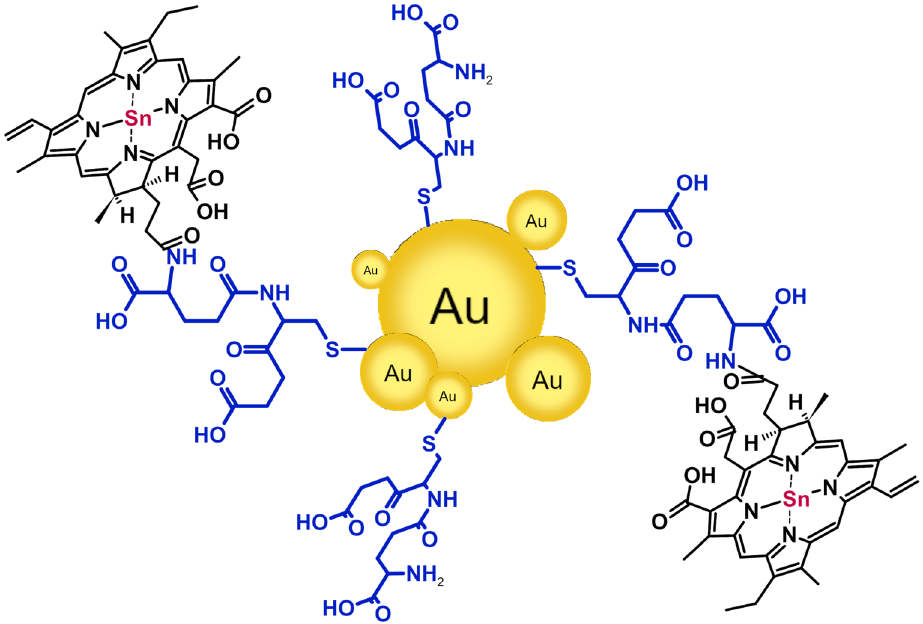
Figure 5. Chemical structure of the conjugate consisting of tin chlorins (black), glutathione linkers (blue), and gold nanoparticles (yellow) [31].